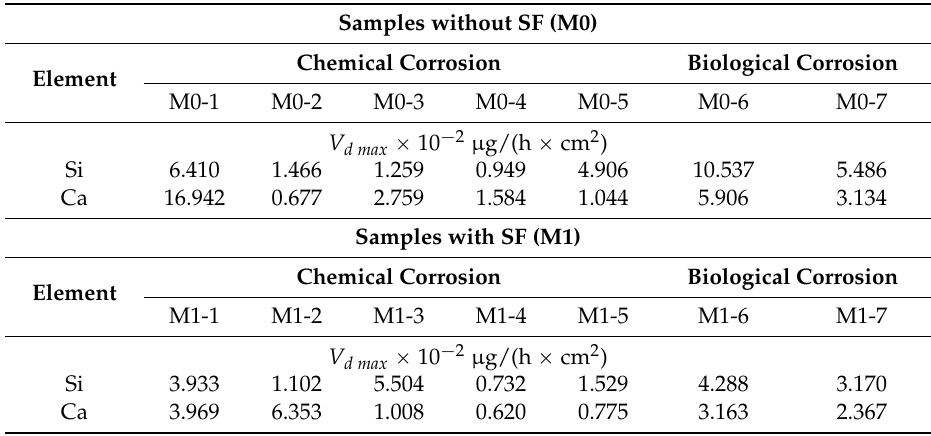
Table 2. The leaching rates of Si and